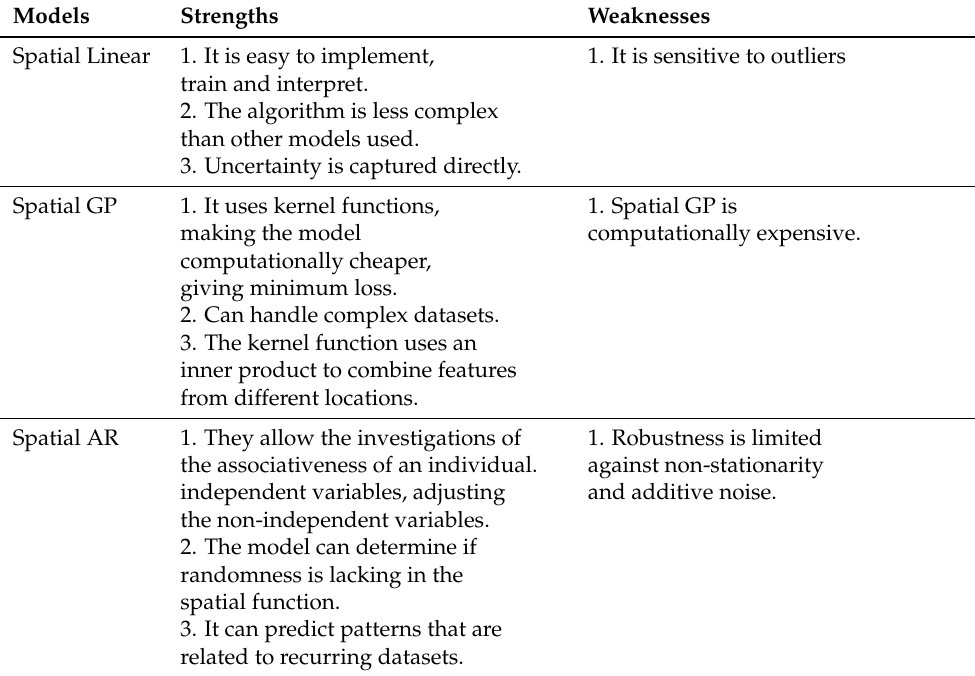
Table 2. Model comparisons of the proposed